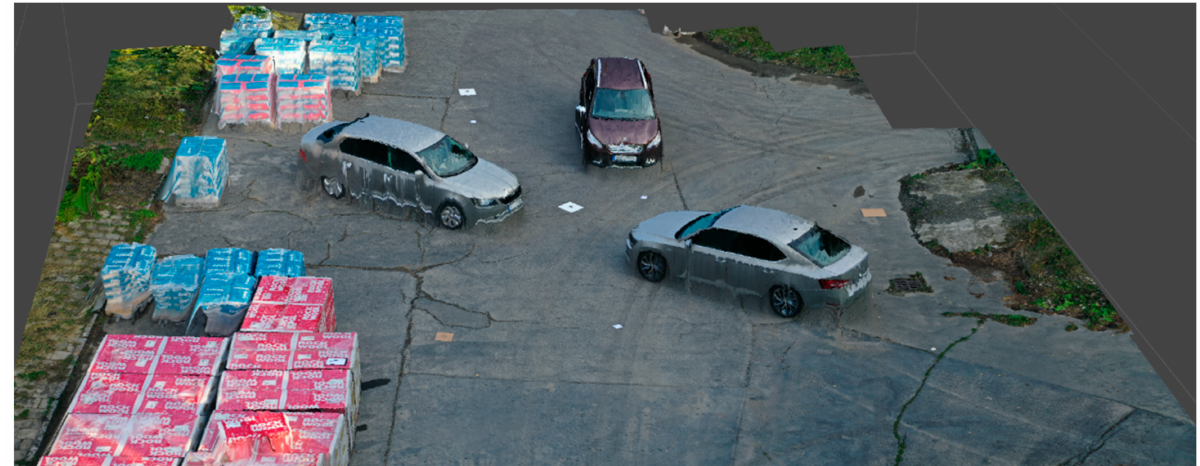
Figure 5. Oblique view to final 3D model (license plates were